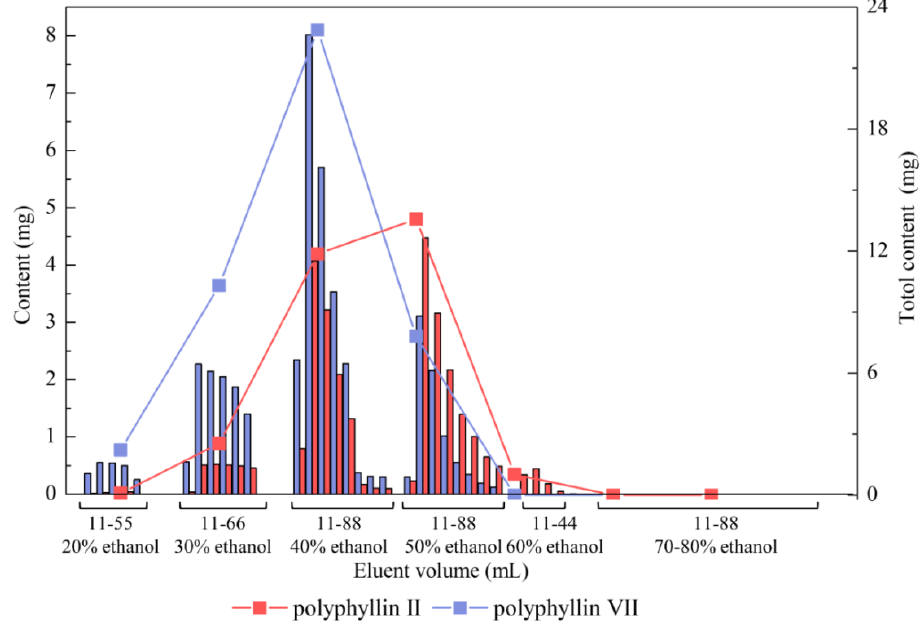
Figure 10. Effects of the concentration and volume of ethanol solution on NKA-9 column separation of two saponins.